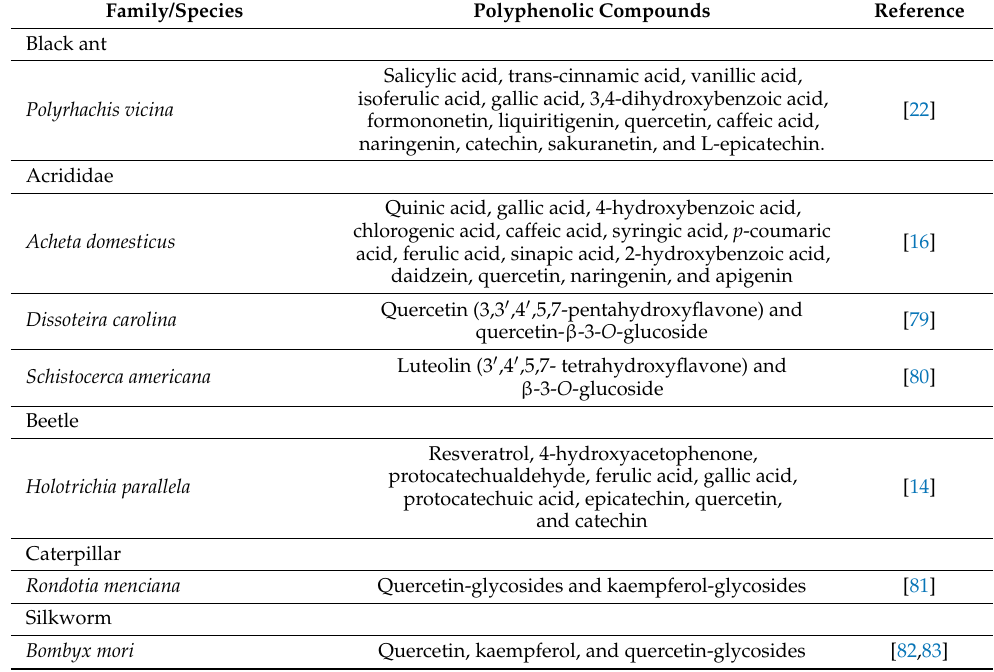
Table 3. Polyphenolic compounds in different species of